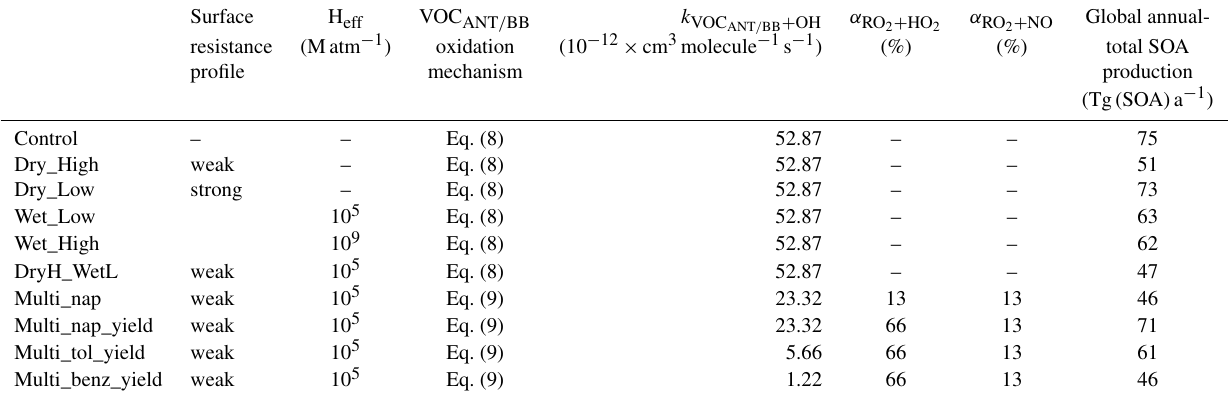
Table 3. Simulations conducted in this study. Surface resistances, Low and High, are shown in Table 2. For both surface resistances and H eff , all SOA precursors are assumed to have identical parameters. The oxidation mechanism for isoprene and monoterpene follows Eq. (8) in all simulations. Emissions for all SOA precursors are identical across all